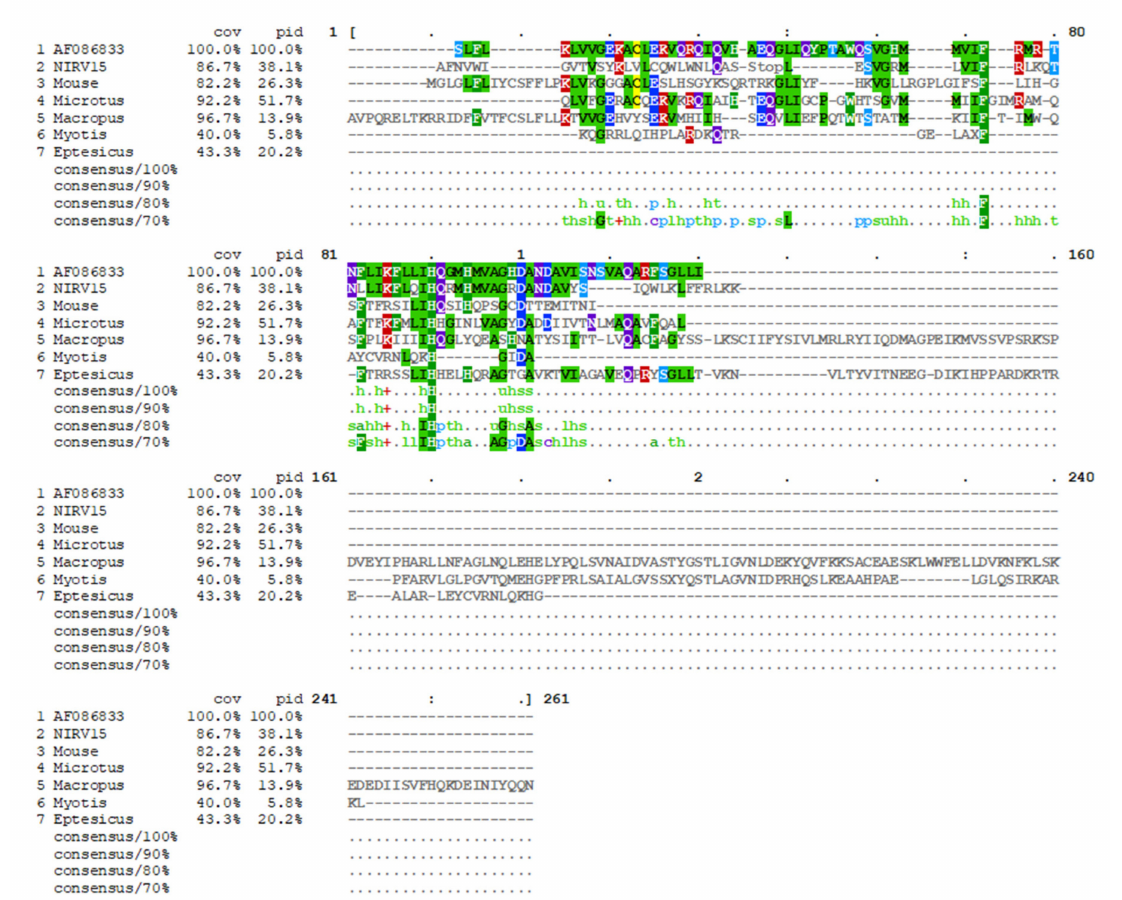
Figure 6. Ebola virus (EBOV)-nonretroviral integrated RNA viruses (NIRVs) alignment and mapping in Guinean bats. Conventional PCR was performed, and the DNA obtained was sequenced and aligned with other EBOV-NIRVs sequences previously described and with EBOV-nucleoprotein (NP)